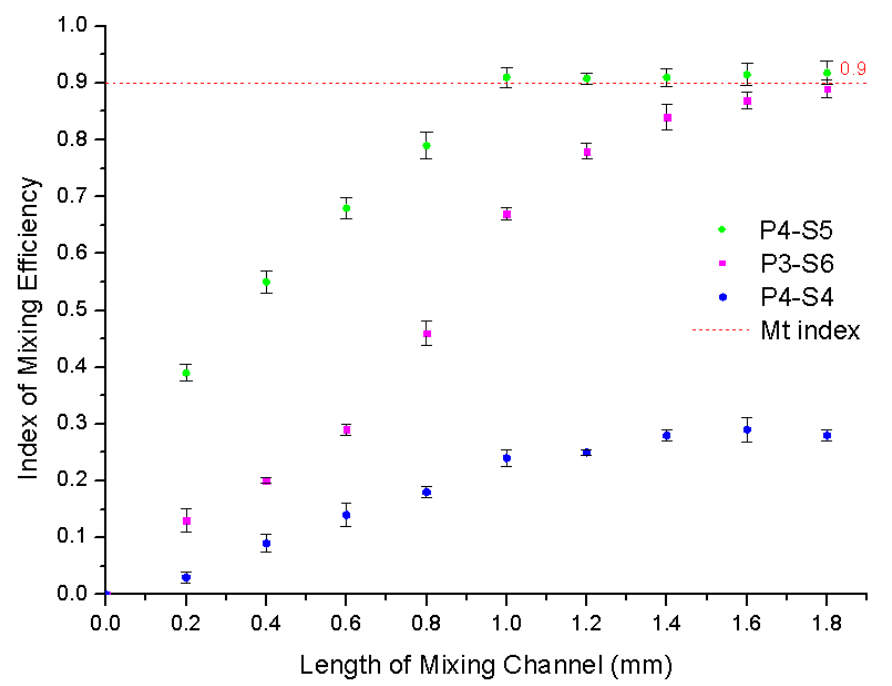
Figure 8. The index of the mixing efficiency with different lengths of the mixing channel.